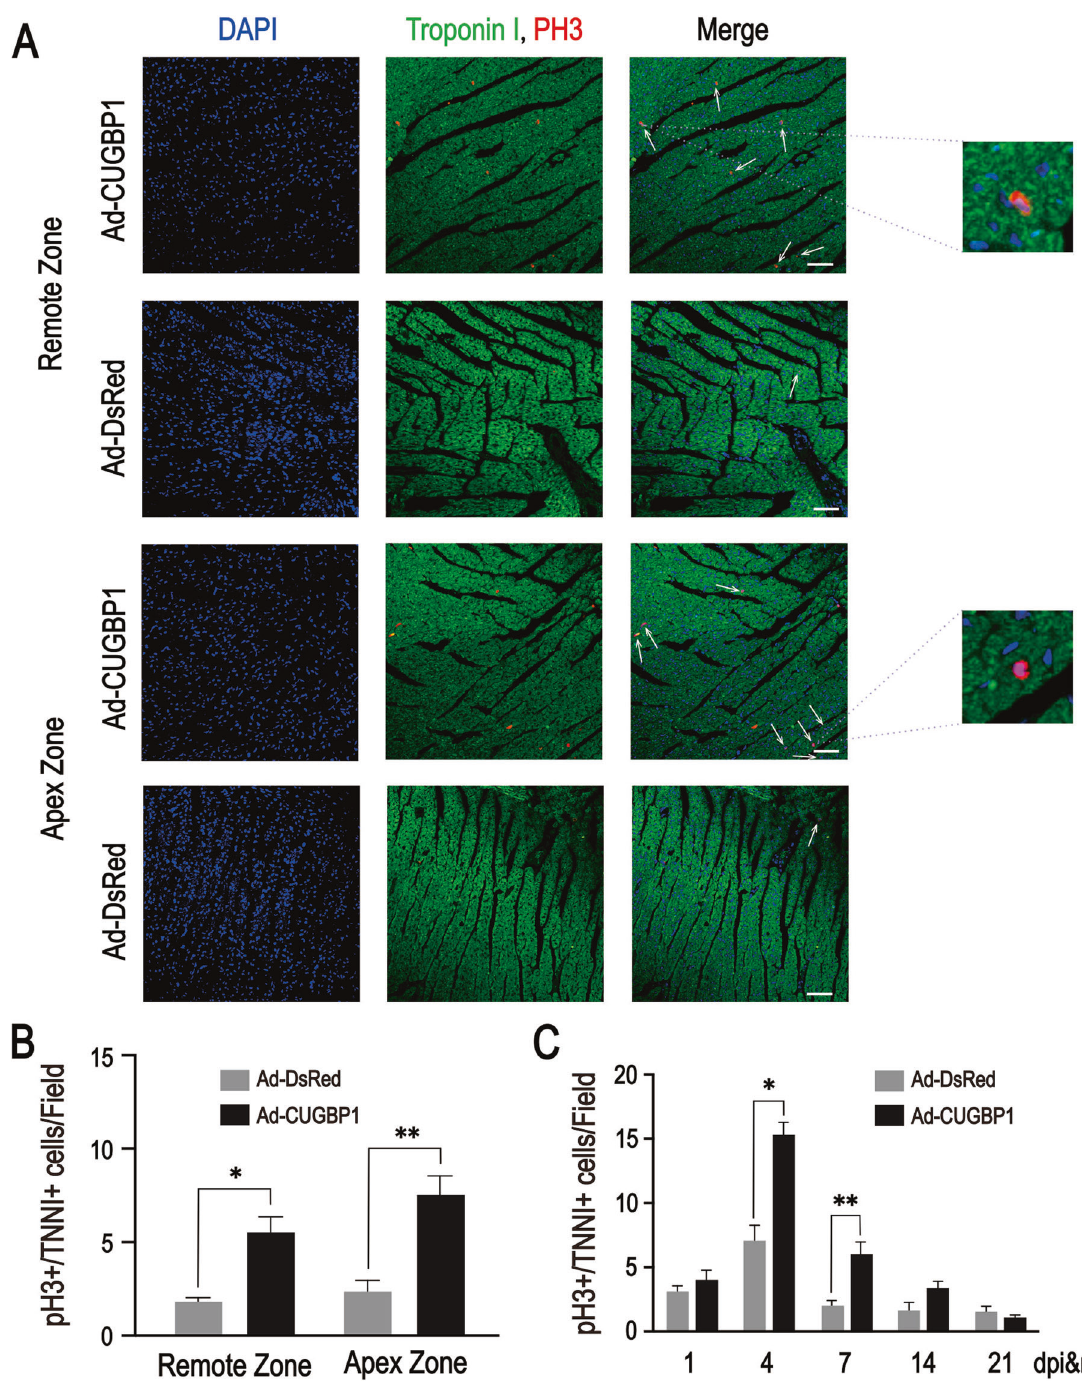
Fig. 3 CUGBP1 promotes cardiomyocyte proliferation in apical resection mice heart. A CUGBP1 was overexpressed in the 14-day old mice hearts and apical resection was performed simultaneously. Seven days after resection, cardiac tissue from apex zone was collected for paraf fi n section immuno fl uorescence detection of PH3 (red) and TNNI (green). Representative images are presented. B Statistical analysis of the number of PH3/TNNI-positive cells in apex and remote zone in the 14-day old mice heart following the Ad-virus infection and resection on seven days after resection. C Statistical analysis of the number of PH3/TNNI-positive cells by paraf fi n sections for immuno fl uorescence in the 14-day old mice heart following the Ad-virus infection and resection. Scale bars: 50 μ m, 10 μ m(inset). Data are presented as the mean ± SEM ( n = 8, 9 fi elds each mouse). * p < 0.05, ** p < 0.01 vs. control. dpi&r, days post injection & resection.